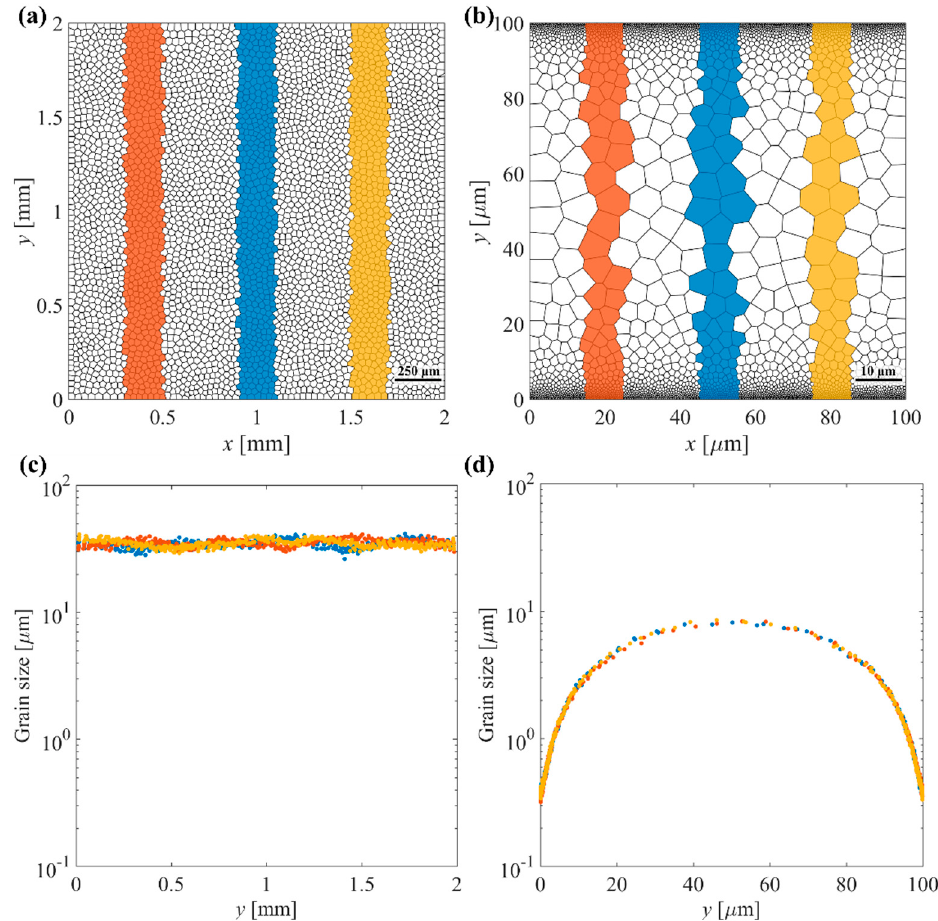
Figure 3. Constructed structures with 35 μ m average grain size for specimens with ( a ) homogeneous structure and ( b ) gradient structure. Corresponding grain size distribution along the y axis for ( c ) homogeneous structure and ( d ) gradient structure.